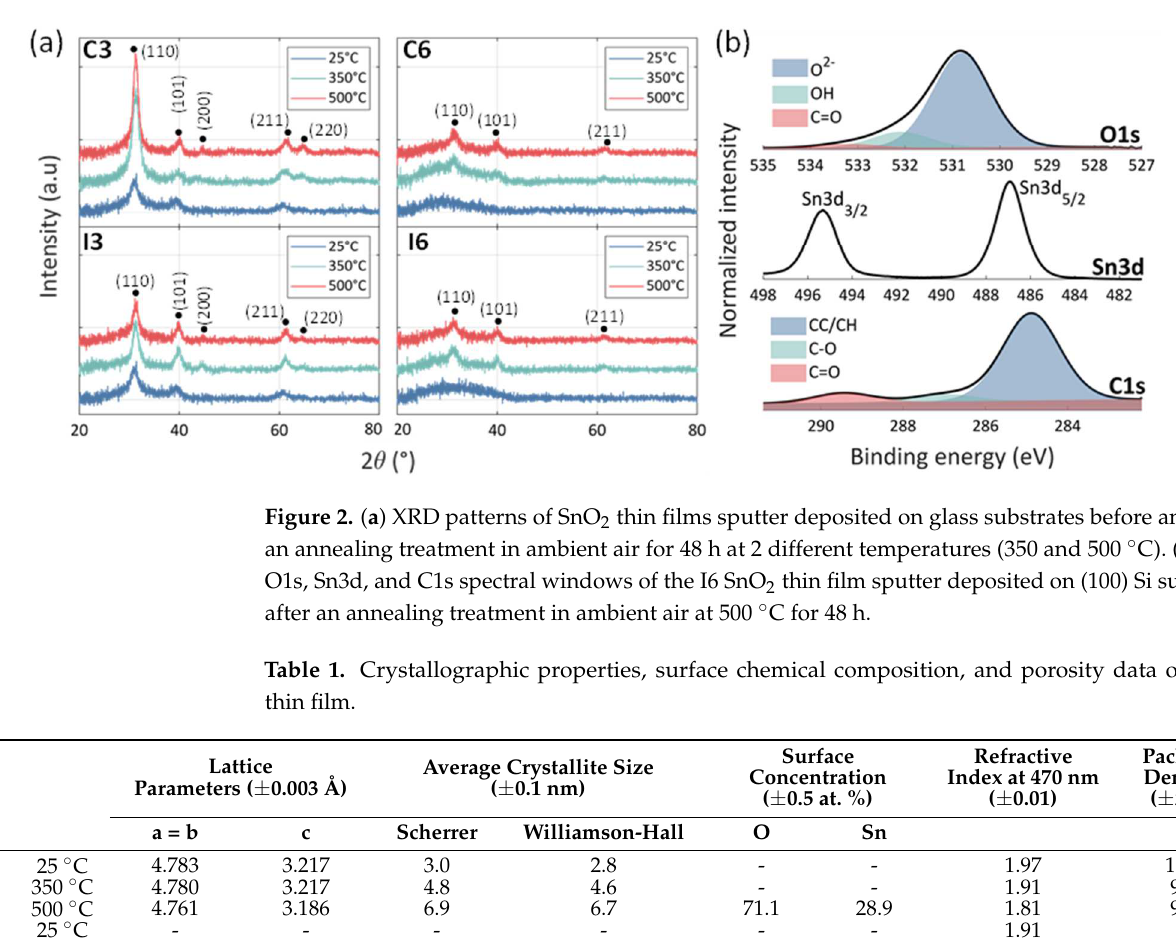
stronger, indicating a better crystallinity. XRD patterns exhibit peaks between 20 and 70° corresponding to the (110), (101), (200), (211), and (220) reflections, which are assigned to